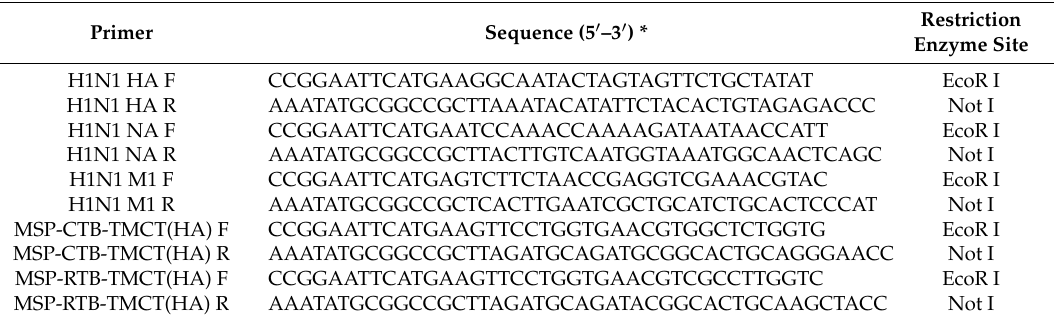
Table 1. Sequences of primers used in present